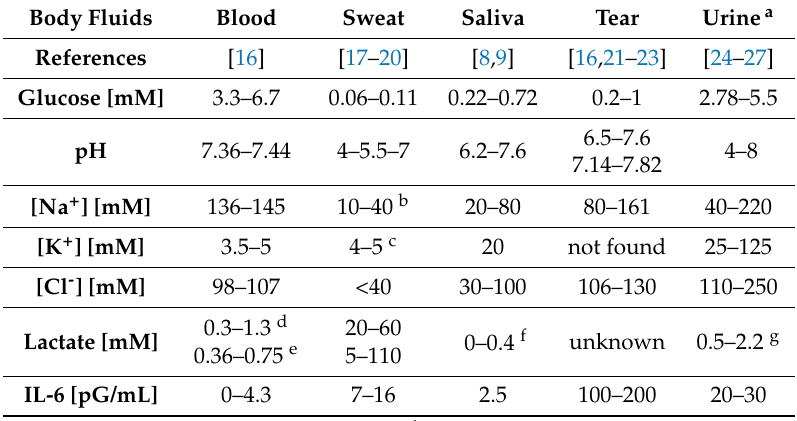
Figure 1. Internet of Wearables concept. Sweat sampling areas in the human body for in situ measurement of physiological analytes and possible wireless access points for data links. Table 1. Normal ranges for analytes of interest in body